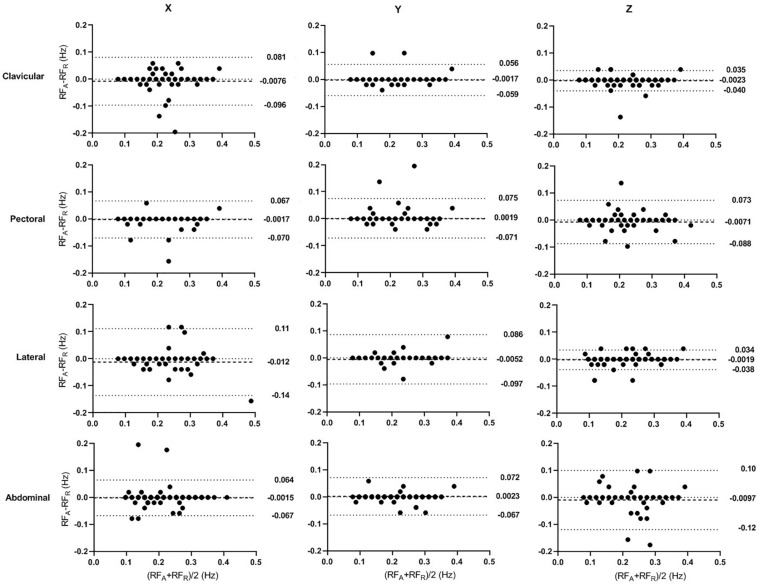
Bland–Altman Plots of the accelerometer-derived and reference RFs in supine posture. The x and y-axes indicate the mean and difference of the accelerometer-derived and the corresponding reference RFs, respectively. The dashed lines show the mean bias. The limits of agreement (LoA) mean ± 1.96 SD interval of difference are given with the dotted lines.